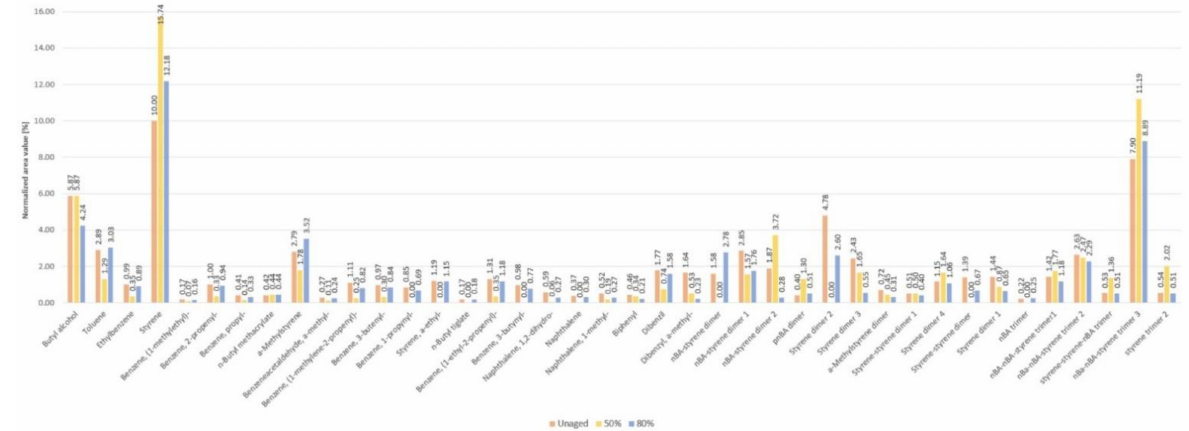
Figure A1. Integrated peak values of normalized areas divided for each compound identified by Py-GC/MS of the pure styrene-acrylic sample. Unaged (red), 50% RH (yellow), and 80% RH (blue) samples values are shown.